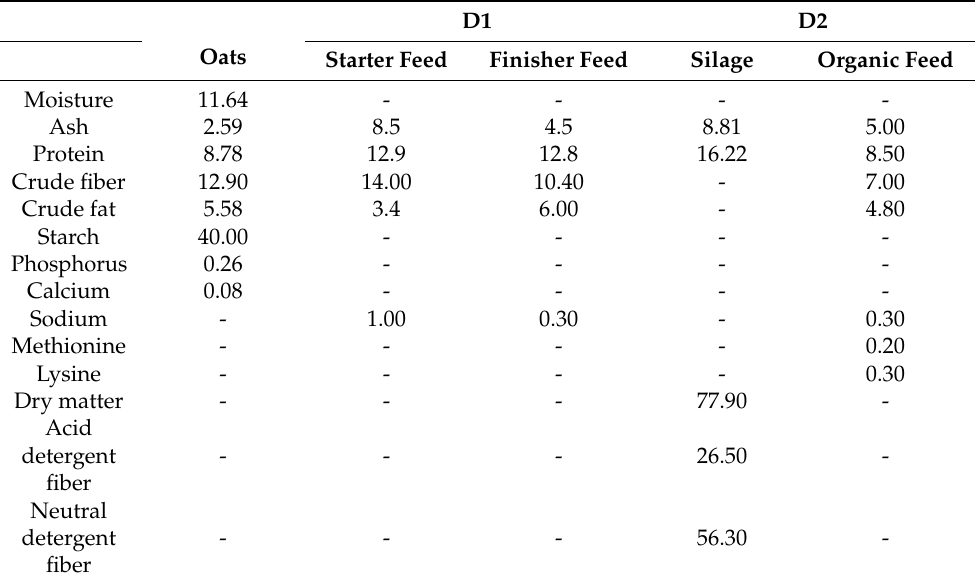
Table 1. Chemical composition (expressed as percentage) of oats, concentrates, and silage allocated to the foals during the fattening period. D1 D2 Oats Starter Feed Finisher Feed Silage Organic Feed Moisture